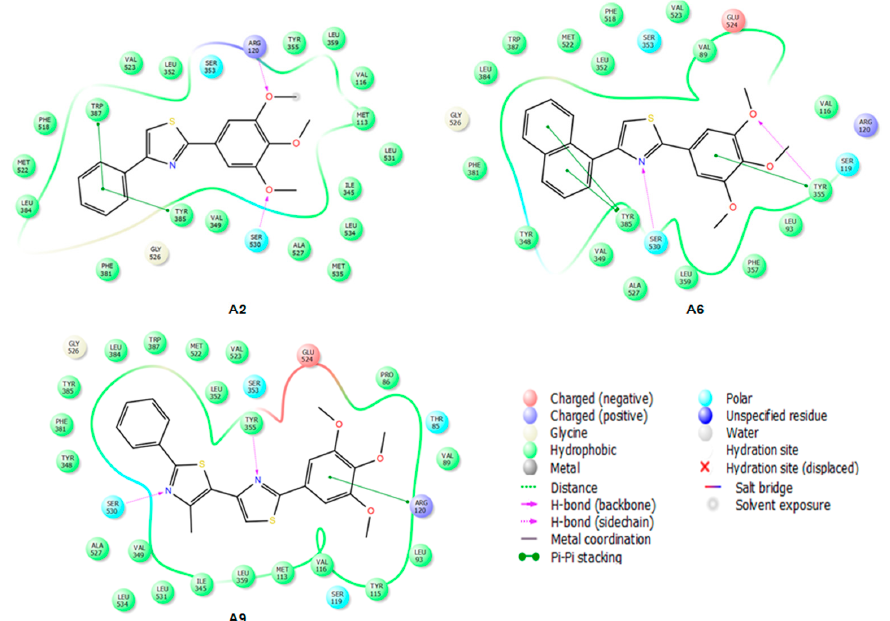
Figure 4. 2D projection of the interactions of compounds A2 , A6 and A9 with the active site of COX-2 (4M11).